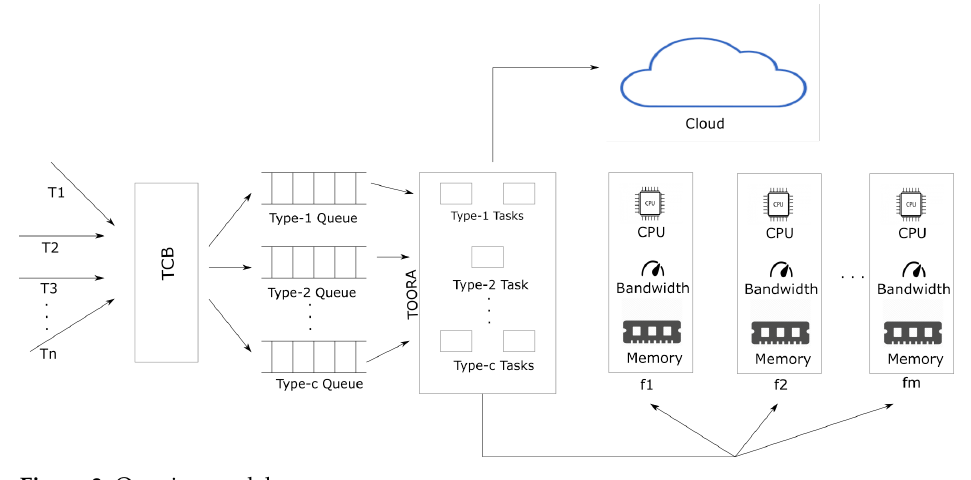
Figure 3. Queuing